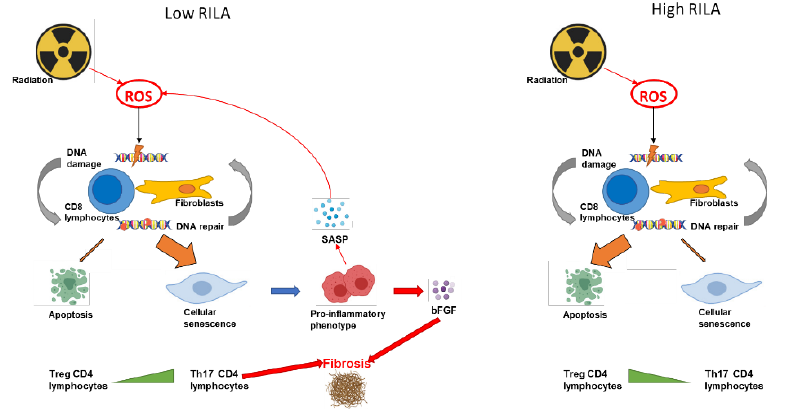
Figure 2. Main hypotheses for RILA molecular